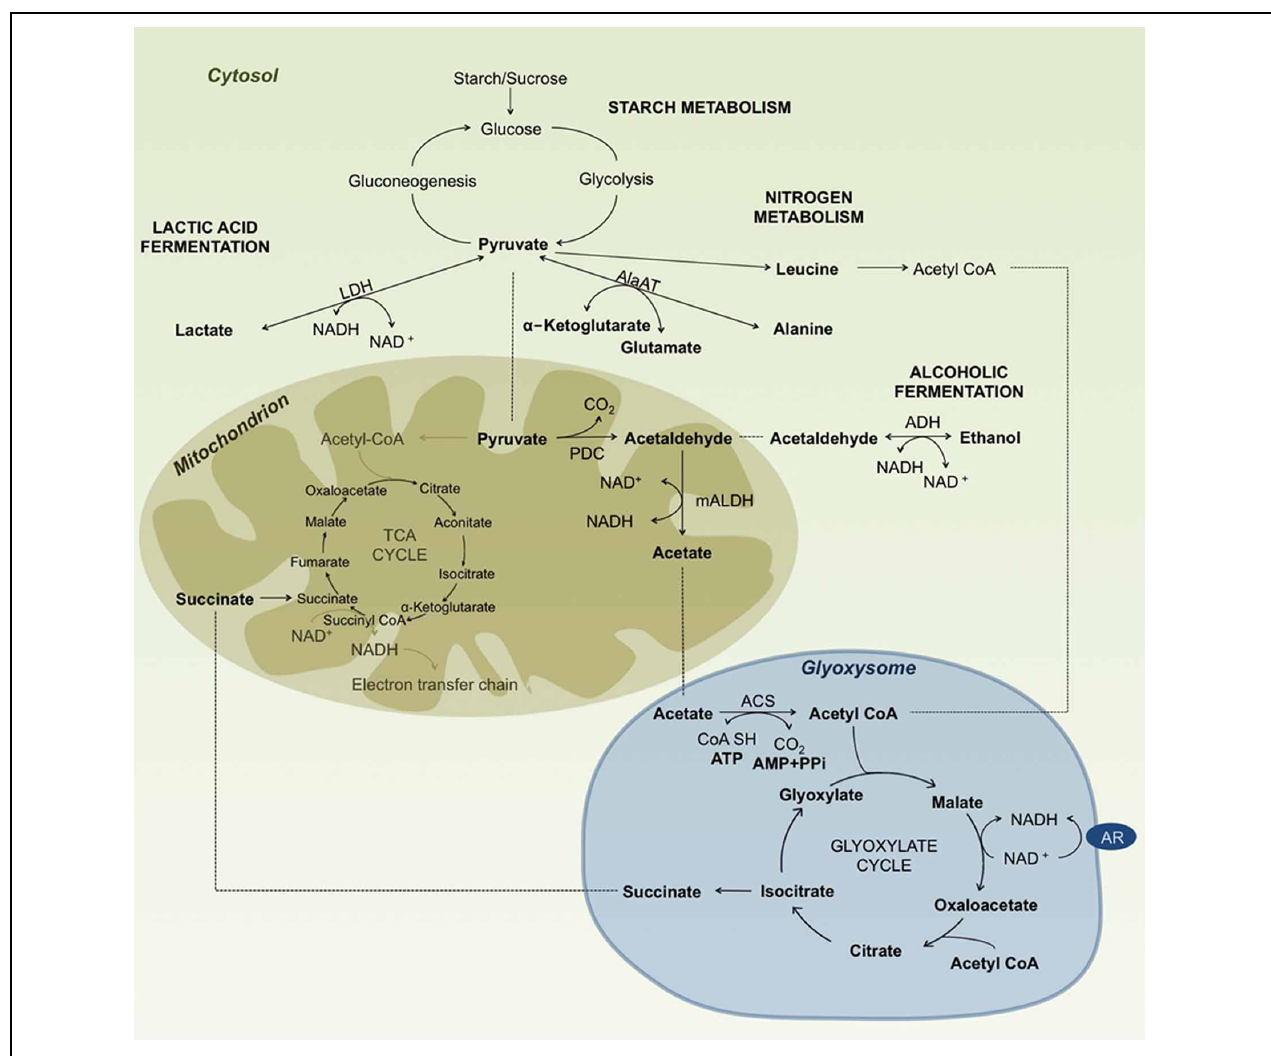
FIGURE 2 | Diagram summarizing carbohydrate metabolism under anoxic/hypoxic conditions in rice. Enzyme abbreviations: AlaAT, alanine aminotransferase (EC 2.6.1.2); LDH, lactate dehydrogenase (EC 1.1.1.27); PDC, pyruvate decarboxylase (EC 4.1.1.1); ADH, alcohol dehydrogenase (EC